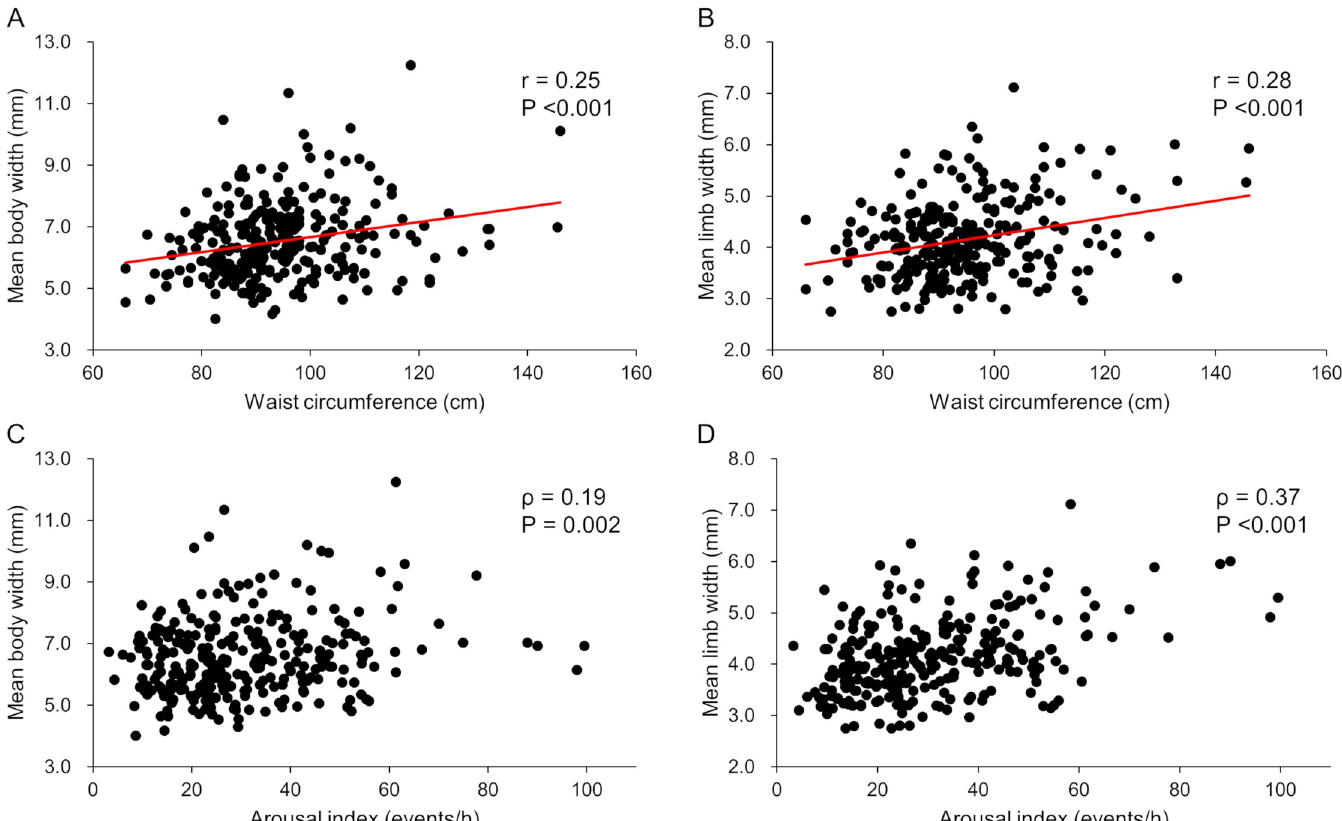
Fig 4. Correlations between mean adrenal limb width or mean adrenal body width and representative sleep and obesity related parameters. (A) Correlation between waist circumference and mean body width. (B) Correlation between waist circumference and mean limb width. (C) Correlation between arousal index and mean body width. (D) Correlation between arousal index and mean limb width. Correlations between adrenal measurements and variables are shown by Pearson correlation analysis (r) or Spearman rank test ( ρ ).